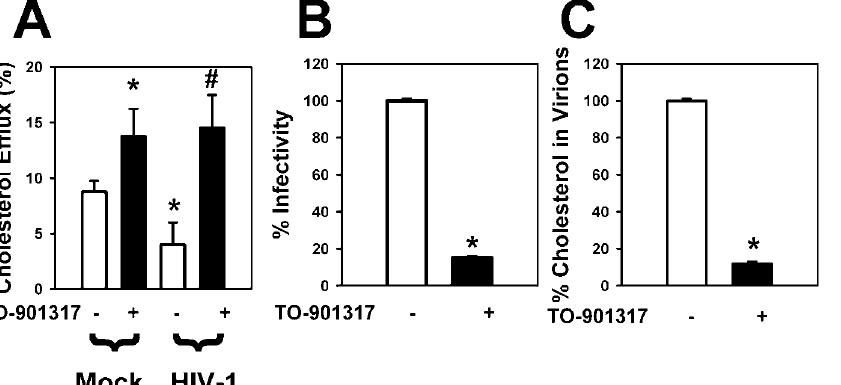
Figure 9. Cholesterol Efflux and Infectivity of HIV Virions Human monocyte-derived macrophages were infected with HIV-1 ADA or mock-infected, and 7 d after infection were treated or not treated with LXR agonist, TO-901317 (500 nM), for seven more days. (A) Cholesterol efflux to apoA-I was measured on day 21 after infection. An asterisk (*) indicates p , 0.01 (versus uninfected cells not treated with TO- 901317); a number sign (#) indicates p , 0.01 (versus HIV-infected cells not treated with TO-901317). (B) Virions were collected from culture supernatants of LXR agonist-treated and untreated (control) cells on day 10 and day 14 (pooled together), adjusted according to p24 content, and analyzed for infectivity on indicator P4-CCR5 cells. Experiment was performed in triplicate, and results (mean 6 SD) are presented as percent infectivity of virions produced by control cells; an asterisk (*) indicates p , 0.001. (C) Incorporation of [ 3 H]cholesterol into virions produced by LXR agonist-treated and untreated (control) cells was measured in triplicate, and results (mean 6 SD) are presented relative to cholesterol in the virions produced by control cells; an asterisk (*) indicates p , 0.001. DOI: 10.1371/journal.pbio.0040365.g009